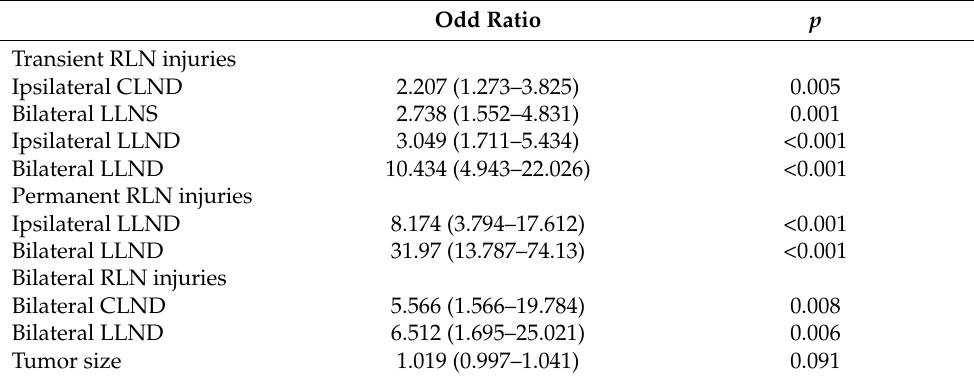
Table 6. Multivariate analysis of predictive factors associated with transient, permanent or bilateral RLN